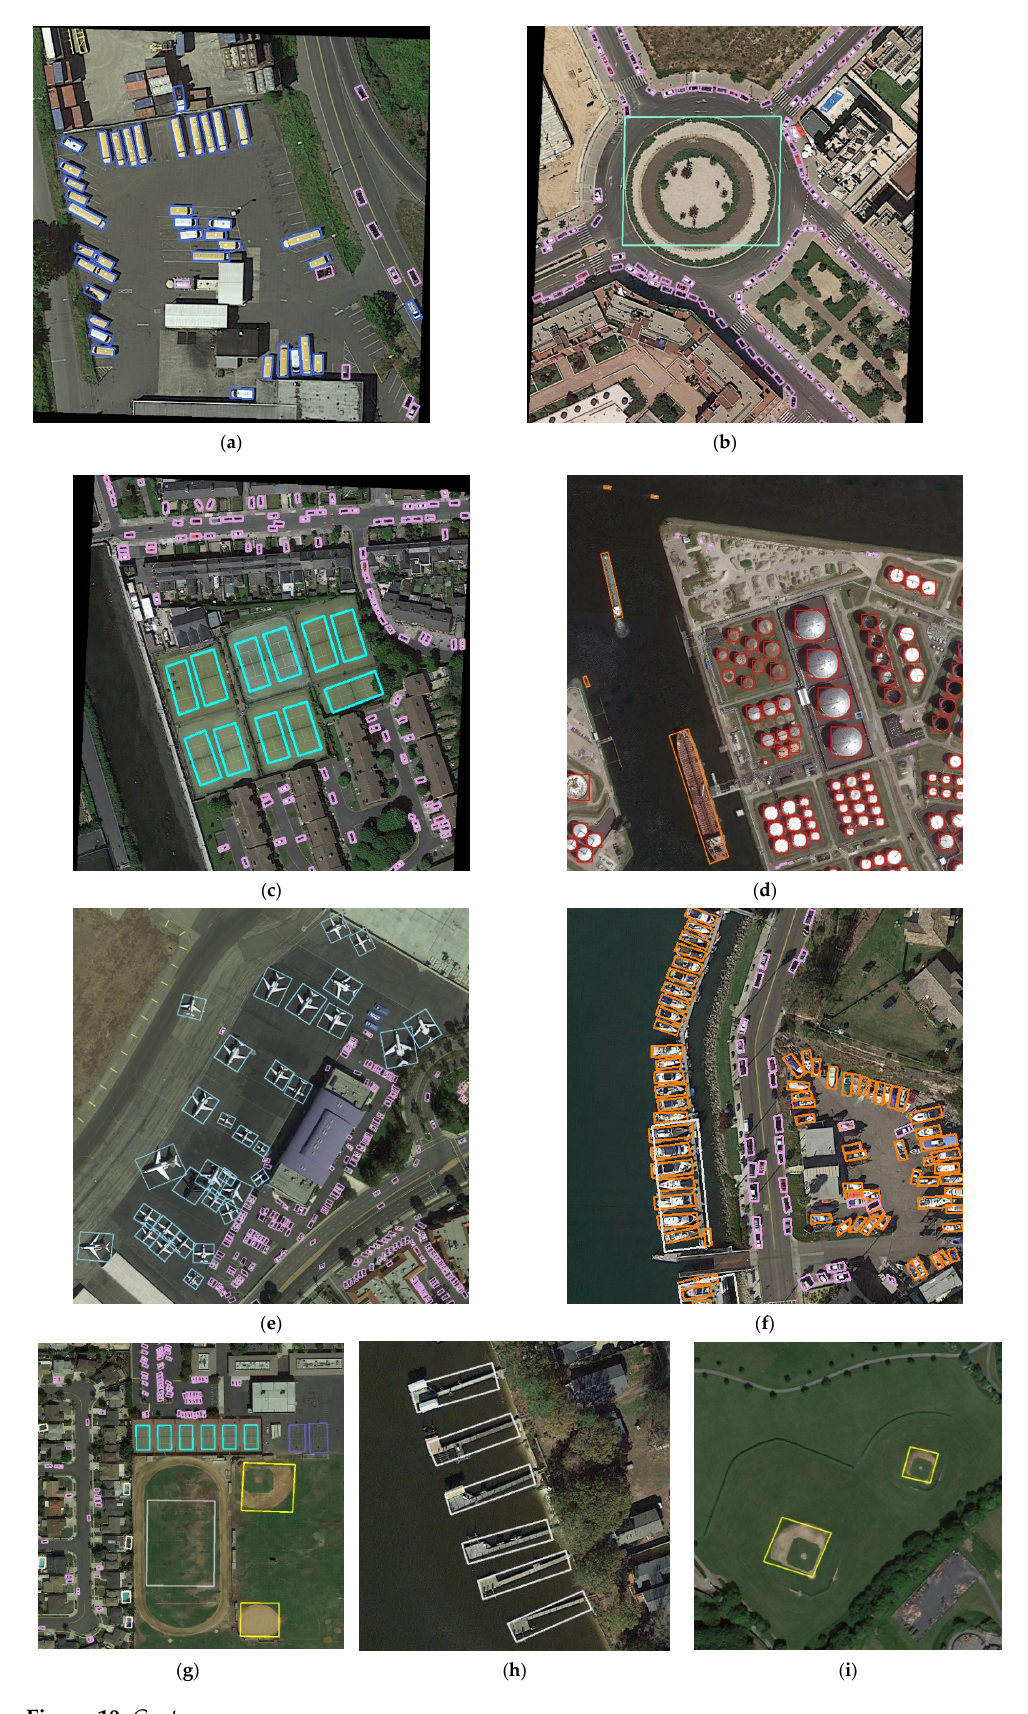
Figure 9. Some visual results of detection with TPR-R2CNN (double head with classification fusion) network (the thresh- old score is 0.5) for the HRSC2016 dataset.